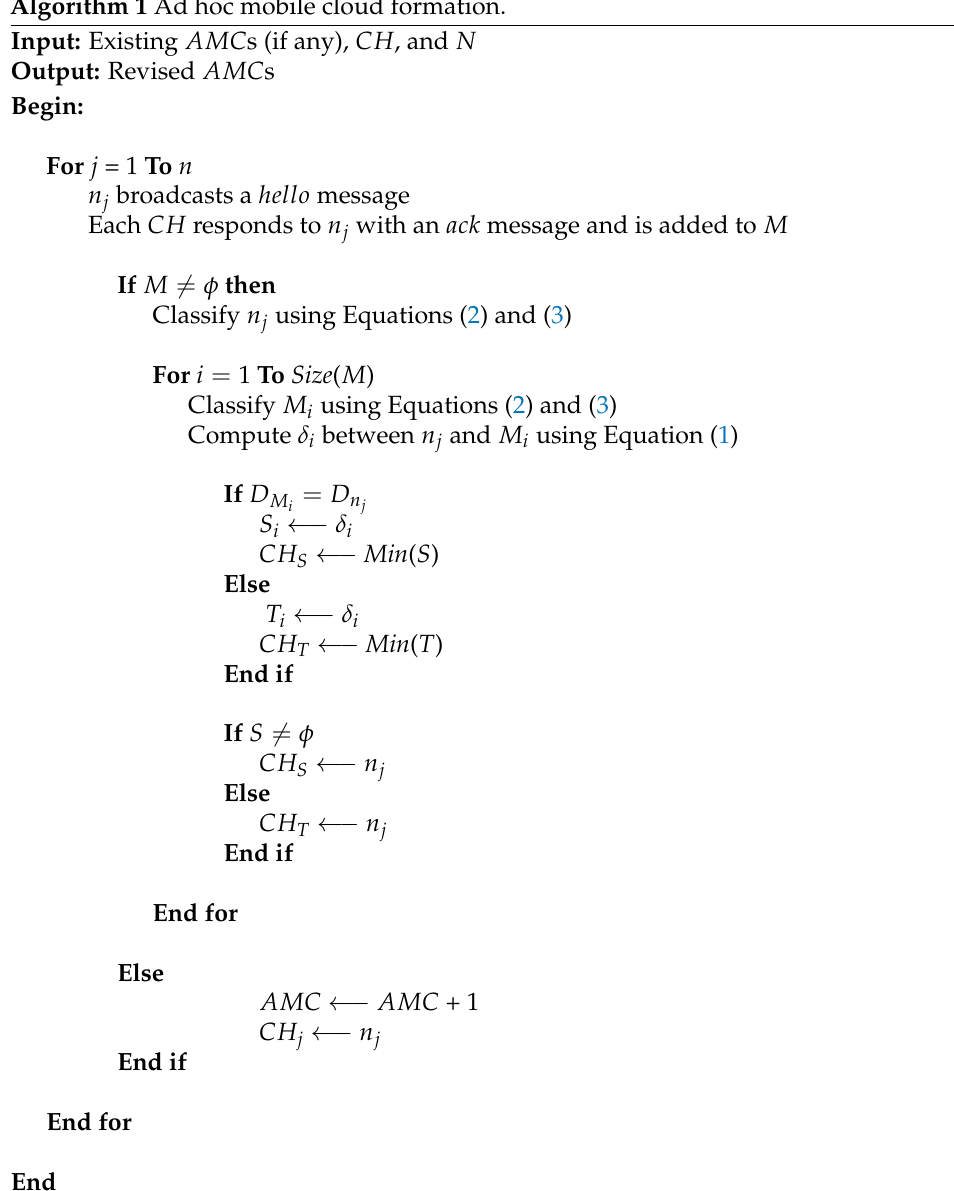
Algorithm 1 Ad hoc mobile cloud